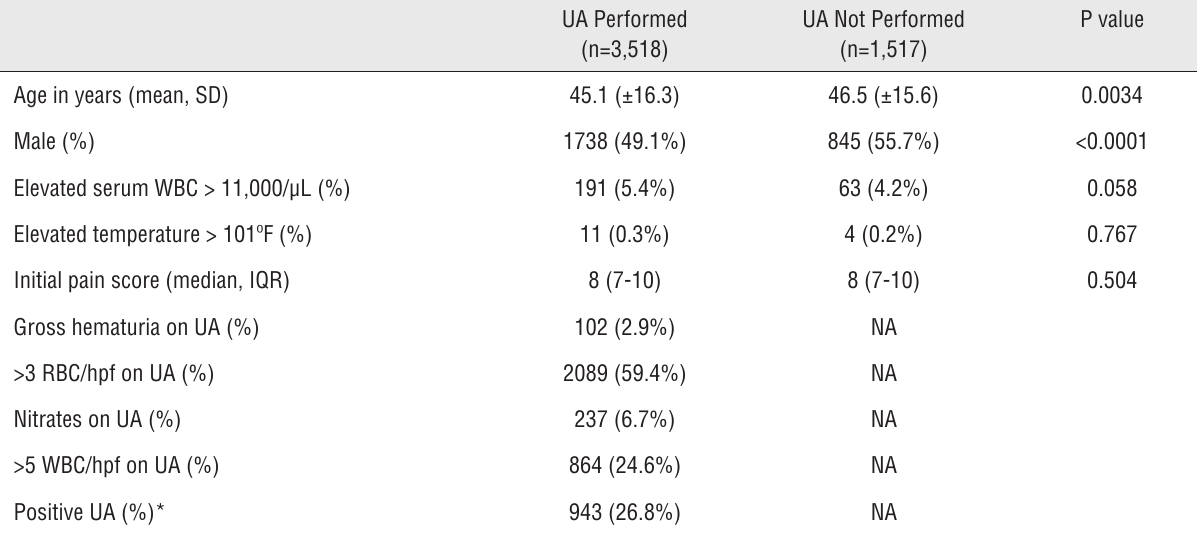
Table 1 - Patient characteristics at ED visits for nephrolithiasis.